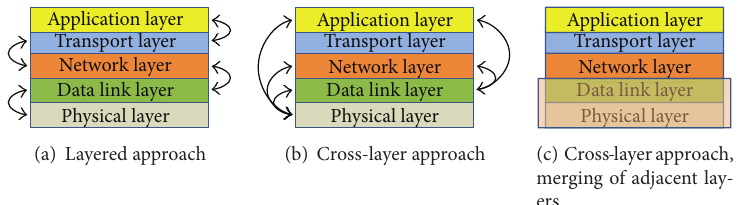
Figure 4: Traditional layered and cross-layer approach.